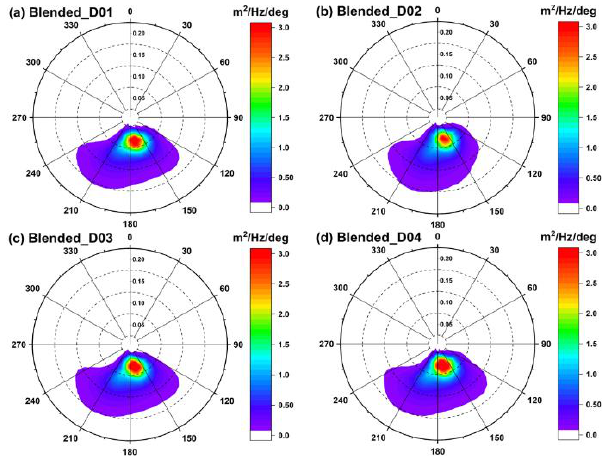
Figure 20. Comparison of the directional wave spectra at the Suao wave buoy at 00:00 on 17 September